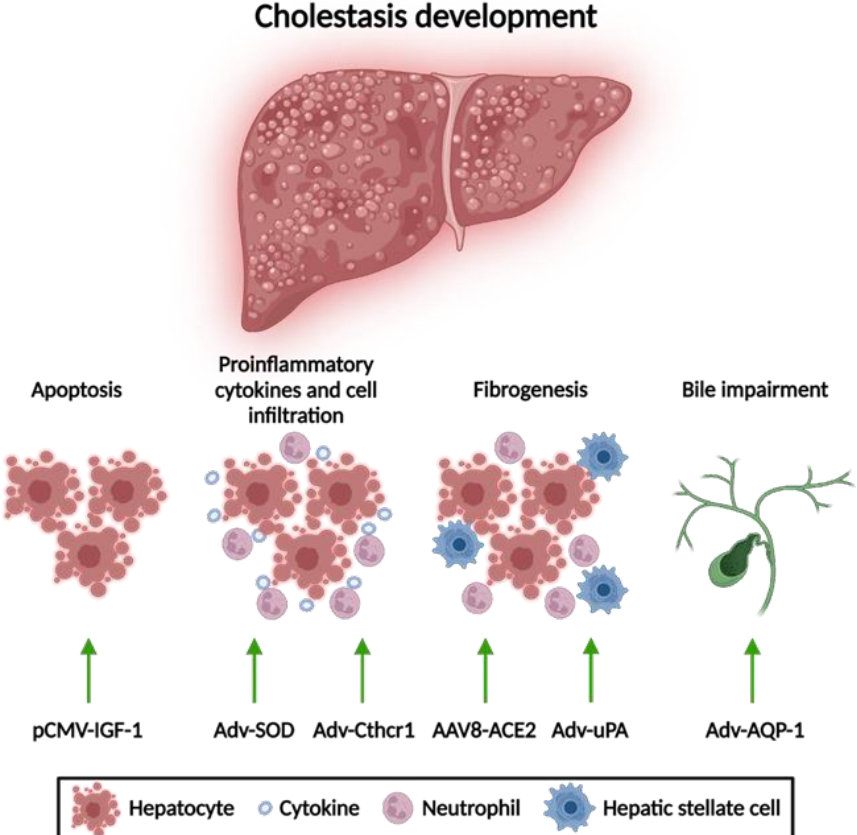
Figure 3. Gene therapy approaches for acquired cholestatic diseases. Different gene therapy strategies have resulted in an alleviation of liver disorders according to their anti-apoptotic, anti-inflammatory, and anti-fibrotic properties, respectively. Adv, adenoviral vector; AAV8, adeno-associated vector with serotype 8; ACE2, angiotensin-converting enzyme; AQP-1, aquaporin; Cthrc-1, collagen triple helix repeat containing-1; HNF4a, hepatocyte nuclear factor 4 alpha; IGF, insulin-like growth factor; SOD, superoxide dismutase; uPA, urokinase-plasminogen activator. This figure was created using BioRender.com.